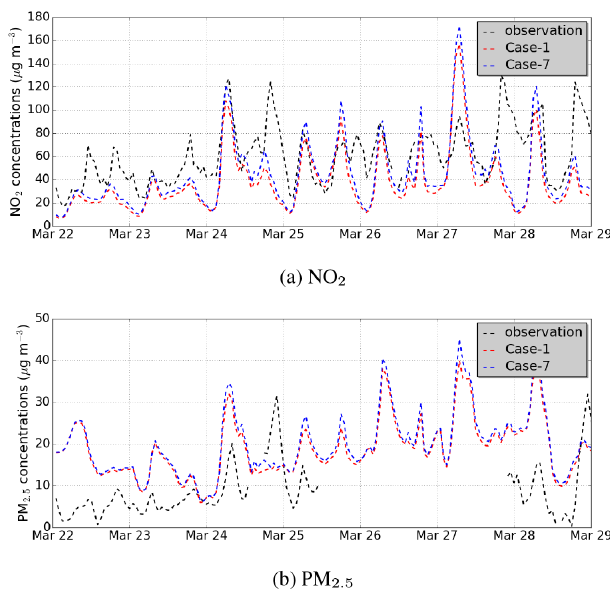
Figure 8. Comparison of observations to (a) NO 2 and (b) PM 2 . 5 hourly concentrations (in µgm − 3 ) obtained using SCHULTE (Case-1, red line) and SIRANE (Case-7, blue